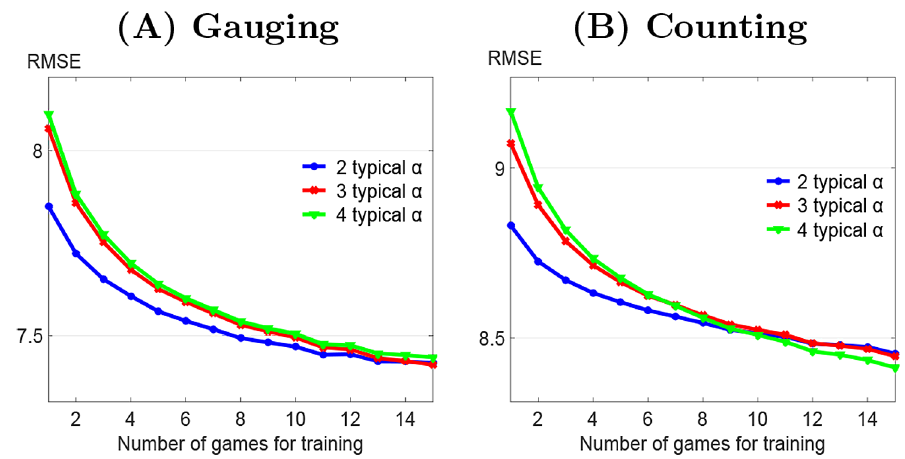
Fig 3. Predictive power of the consensus model when the number of typical couples of influenceability used for model calibration varies. Root mean square error ( RMSE ) plotted for training set size from 1 to 15 games. (A) gauging game , (B) counting game . In (B), RMSE has been scaled by a factor of 5 to be comparable to the (A)